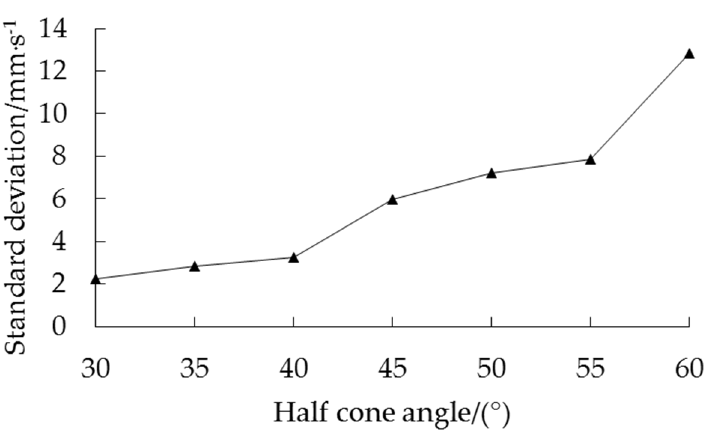
Figure 14. Standard deviation of the average velocity in 1 s in the periodic pulsation period with a half cone angle in the range of 30–60°.